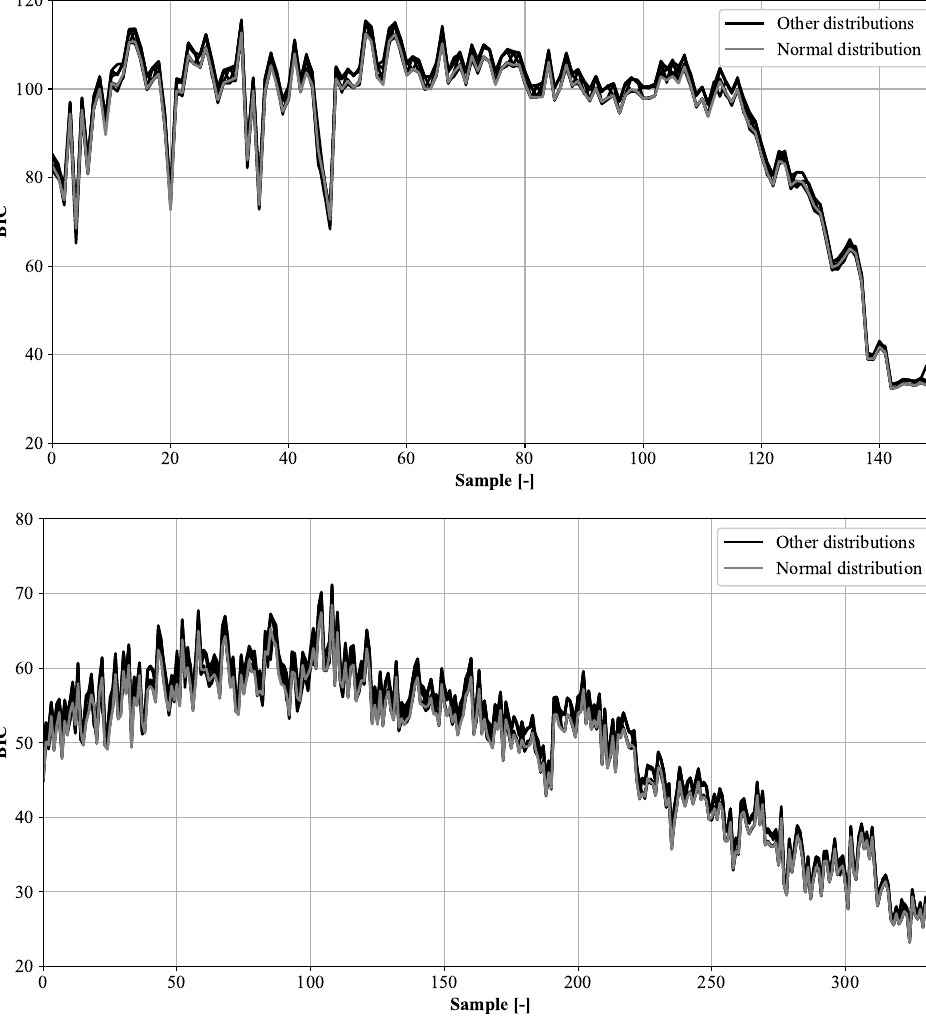
Figure A2. BIC-values of all relevant distributions for each sample of setup I ( Top ) and II ( Bottom